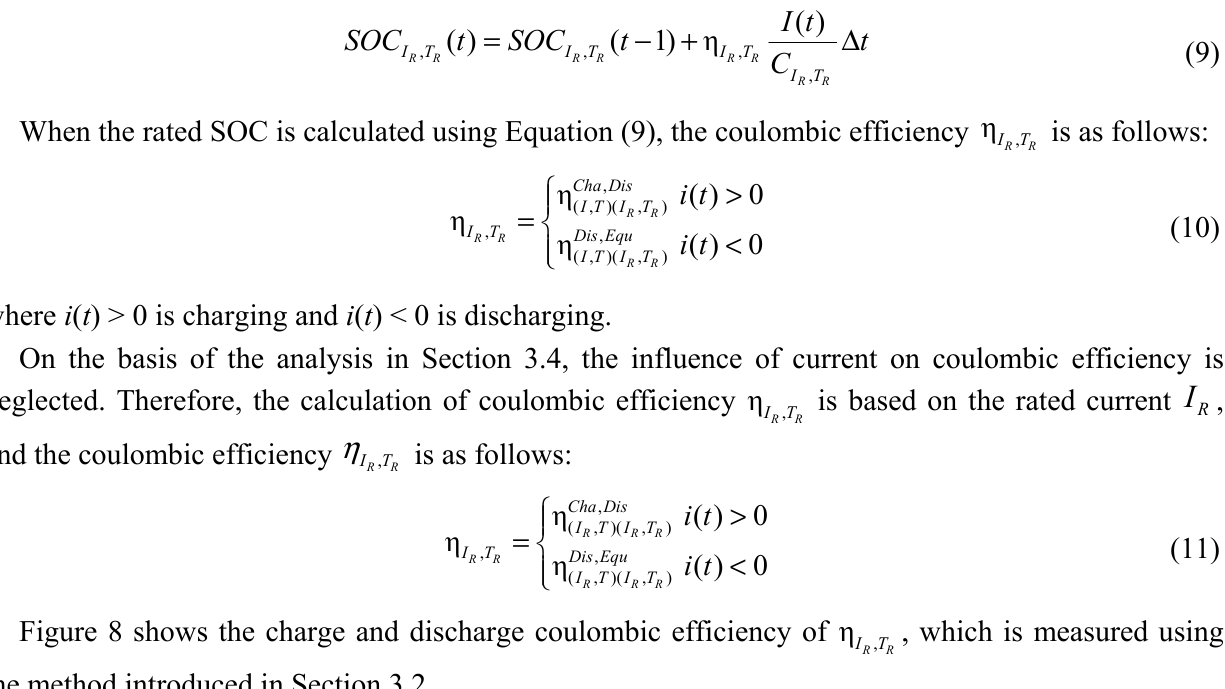
Figure 8. The coulombic efficiency